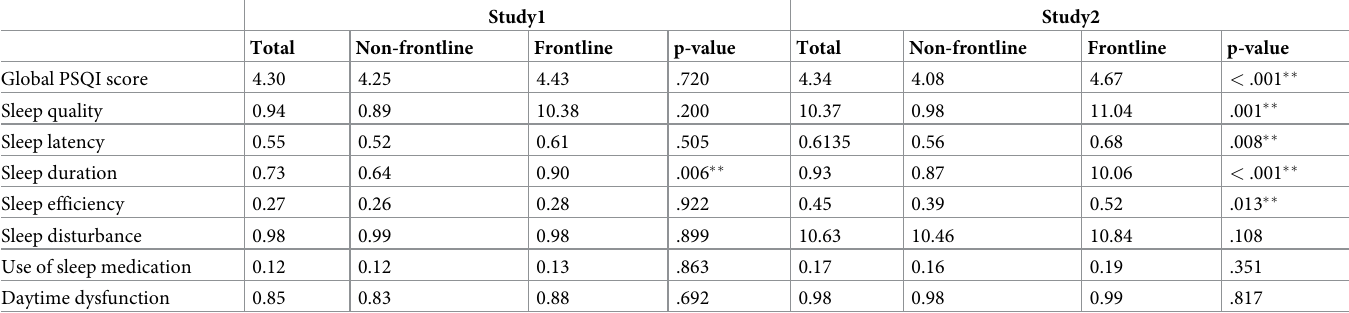
Table 2. T-Test of global PSQI score and individual components of